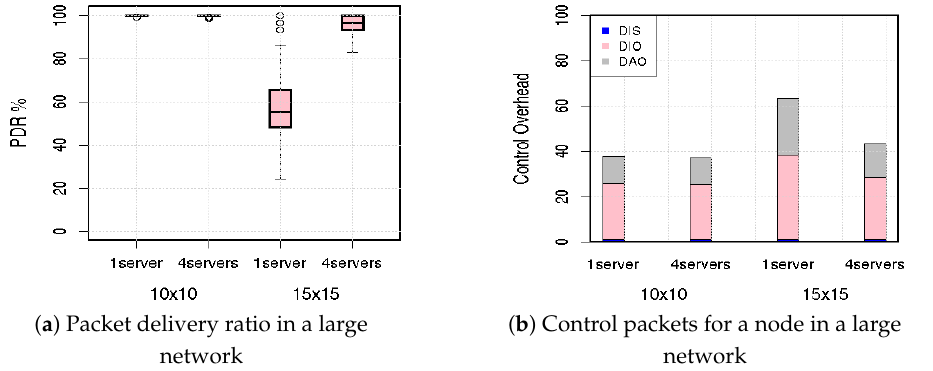
Figure 11. Performance in a 10 × 10 grid vs. 15 × 15 grid. ( a ) Data reliability in the network. ( b ) Control overhead in the